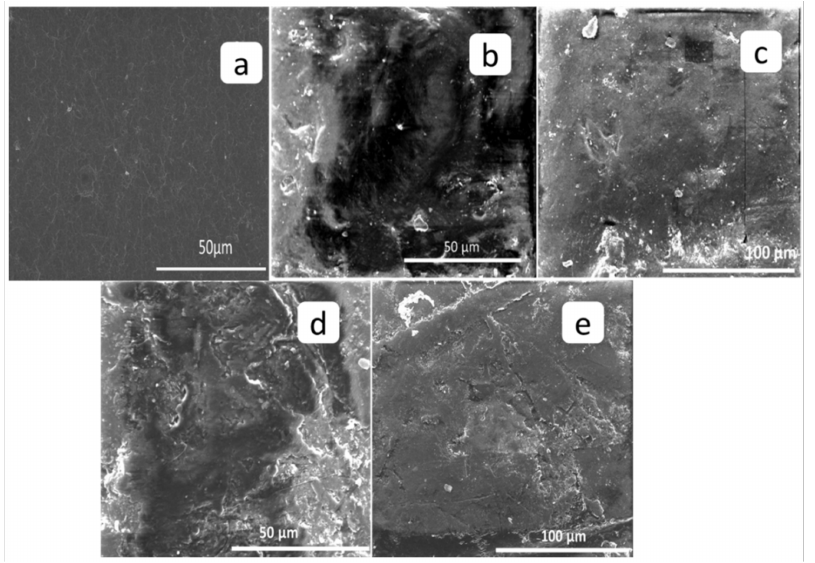
Figure 3. SEM images of ( a ) pure TPU, ( b ) TPU 3 (50 µ m), ( c ) TPU3 (100 µ m), ( d ) TPU-6 (50 µ m), and ( e ) TPU-6 (100 µ m).